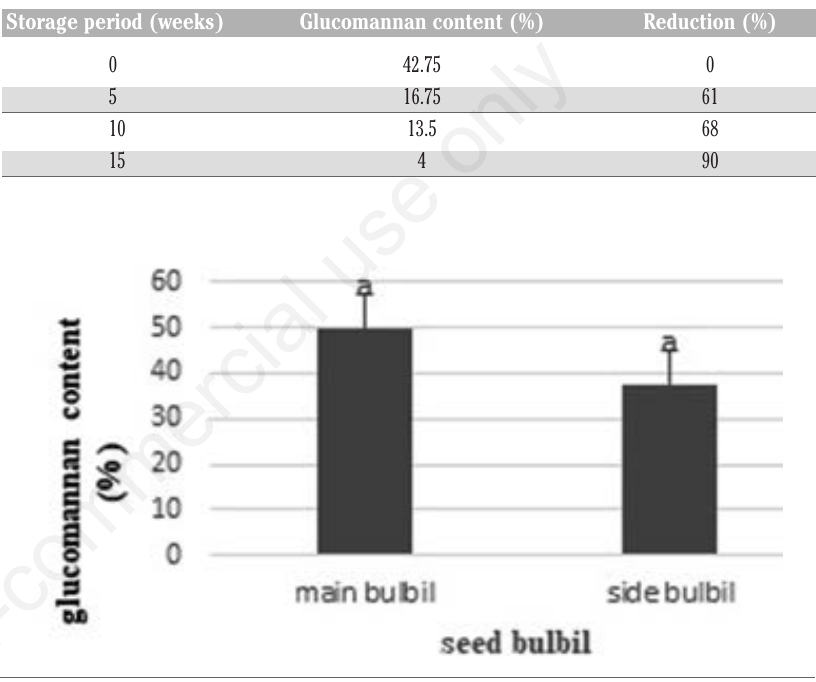
Figure 3. Glucomannan content of tubers derived from main and side bulbils. Note: Different letters indicate significant differences in the t test at